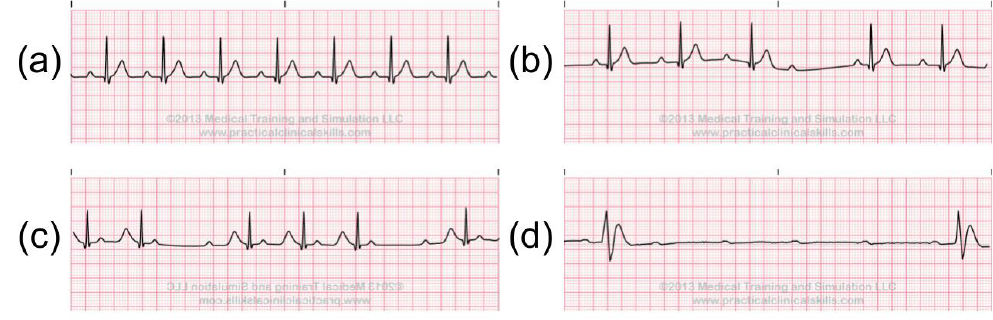
Figure 8. AV Blocks: ( a ) First-degree AV blocks, ( b ) Second-degree AV blocks type I, ( c ) Second-degree AV blocks type II, ( d ) Third-degree AV blocks [21].